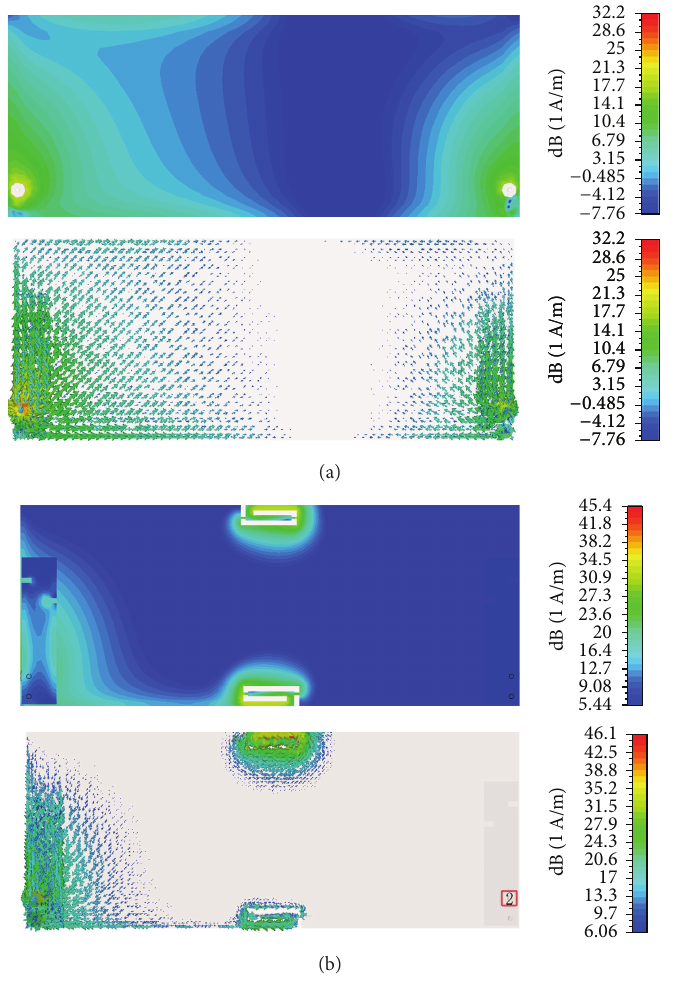
Figure 8: Current distributions of the two PIFAs (a) without and (b) with two double-layered structures.